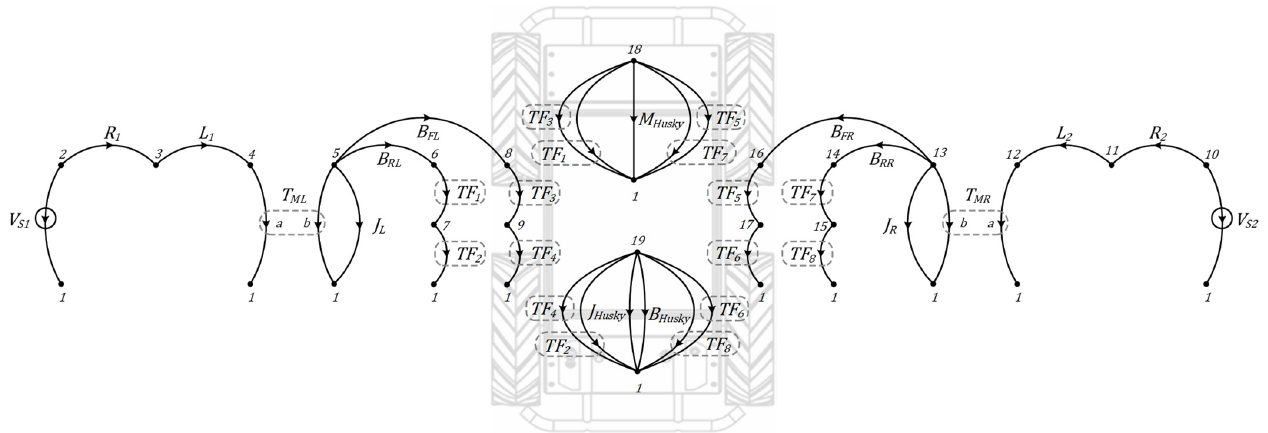
Figure 10. Complete LG model of the ClearPath Husky robot with the simplified drivetrain sub-systems.